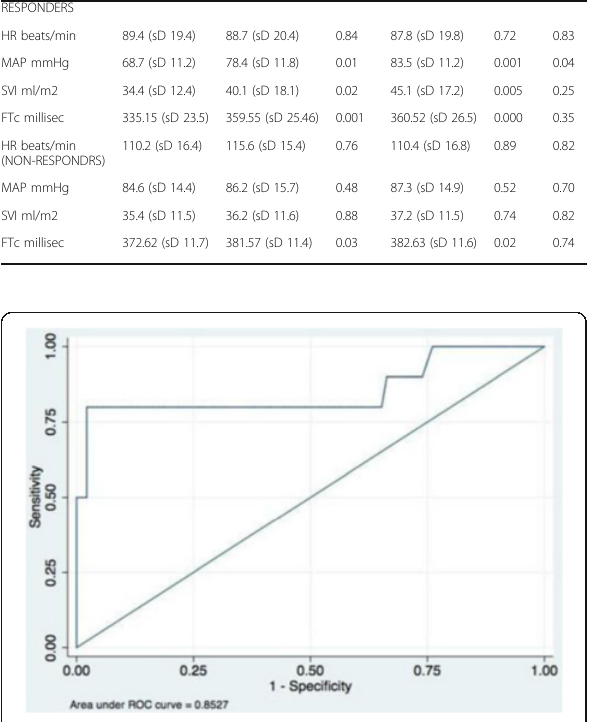
Fig. 6 (abstract A11). ROC curve for carotid flow